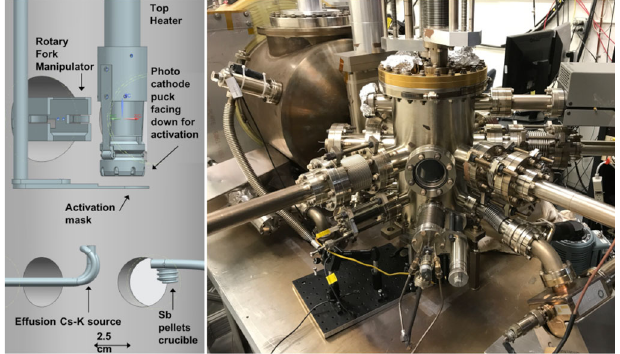
FIG. 3. Left: Diagram of the photocathode activation vacuum chamber internal components showing the photocathode puck facing down behind the mask for photocathode fabrication. Right: Photograph of the photocathode activation vacuum chamber. The photogun high voltage chamber can be seen in the foreground, with the gate valve separating the two